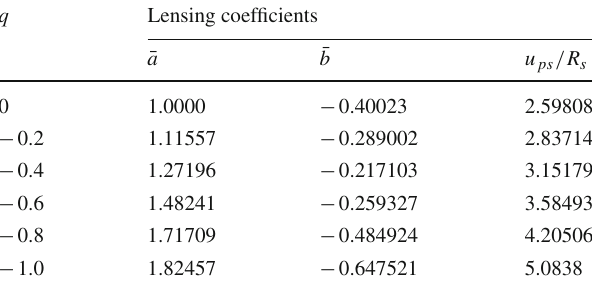
Table1 Estimatesforthestronglensingcoefficients ¯ a , ¯ b andthecritical impact parameter u ps / R s for the hairy black hole in Horndeski gravity. The values at q = 0 corresponds to the Schwarzschild black hole. ¯ a , ¯ a are dimensionless whereas u m is in the units of Schwarzschild radius